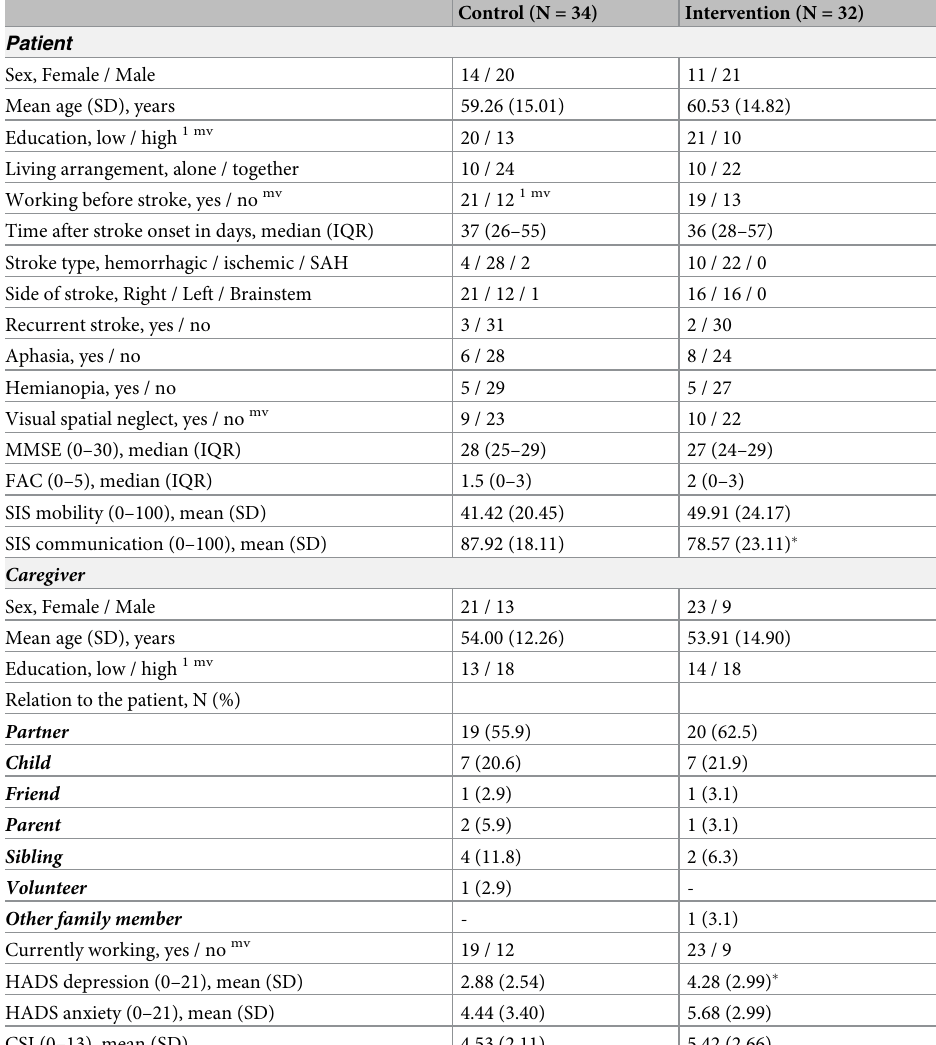
Table 1. Baseline characteristics of